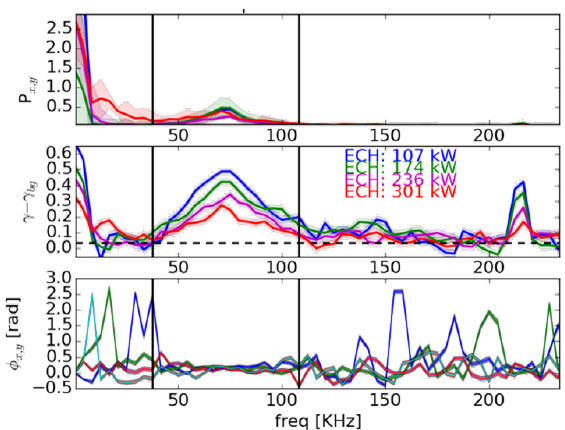
Fig. 7. Cross-power, coherence, and phase (top to bottom) between the CECE-RF and CECE-IF channels during an experiment with varying ECCD in Heliotron